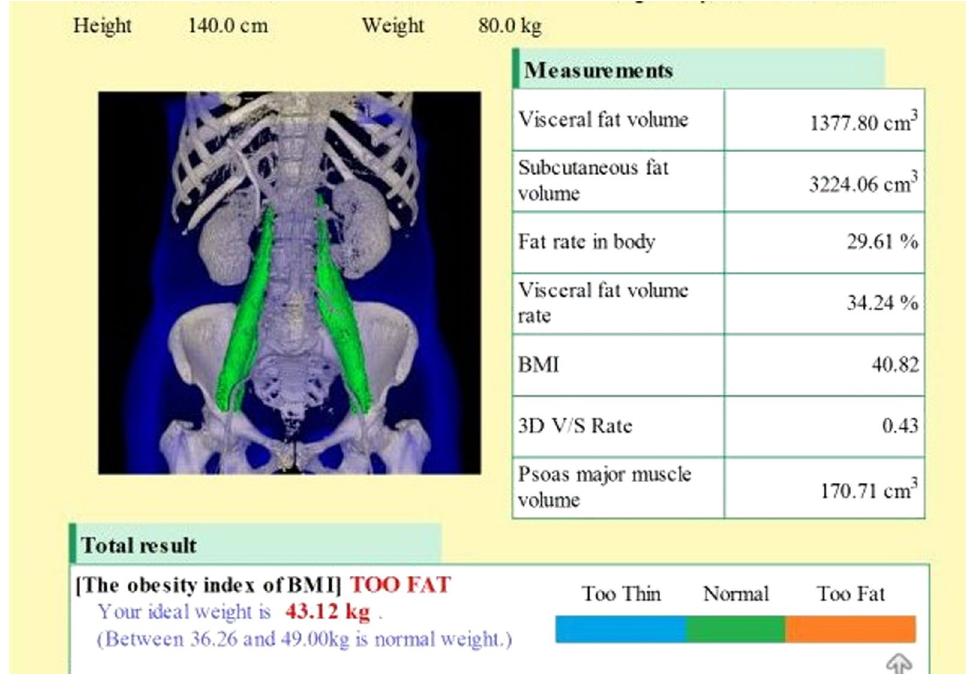
Fig. 4 Automatically generated report of the visceral and subcutaneous fat and psoas muscle volume